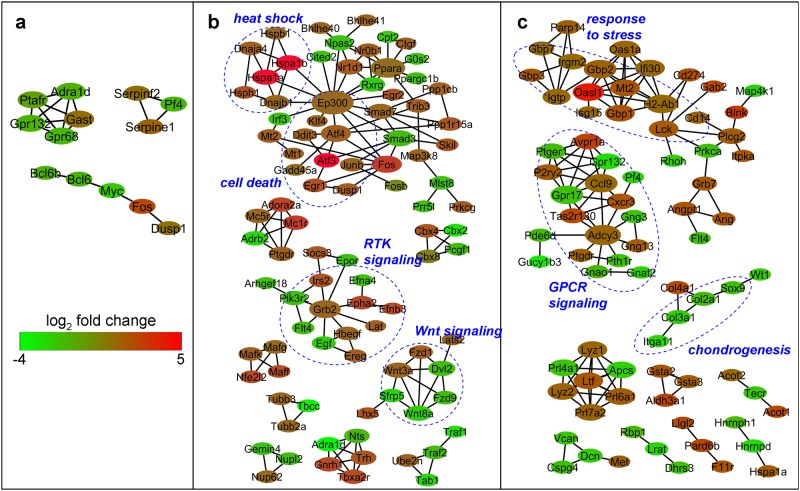
Network of genes modulated by high HP.Network representation of the protein-protein interactions between genes that were significantly (p<0.015) modulated after 1 h (a), 4 h (b) or 24 h (c) of pressurization. Each node represents a protein. Only networks with at least three nodes are shown. The fold change is indicated by the color scale. In order to highlight the more important nodes, the size of the node increases with the number of interacting partners.